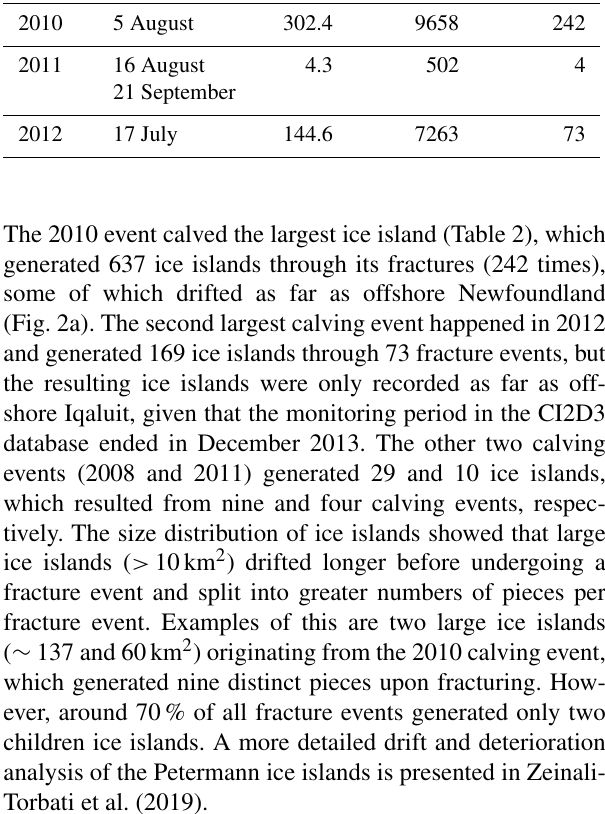
Table 2. Description of the ice islands originating from the massive calving events of Petermann Glacier in 2008, 2010, 2011, and 2012. Glacier Main Surface Number of Number of calving calving area digitized fracture year date (km 2 ) polygons events 2008 10 July